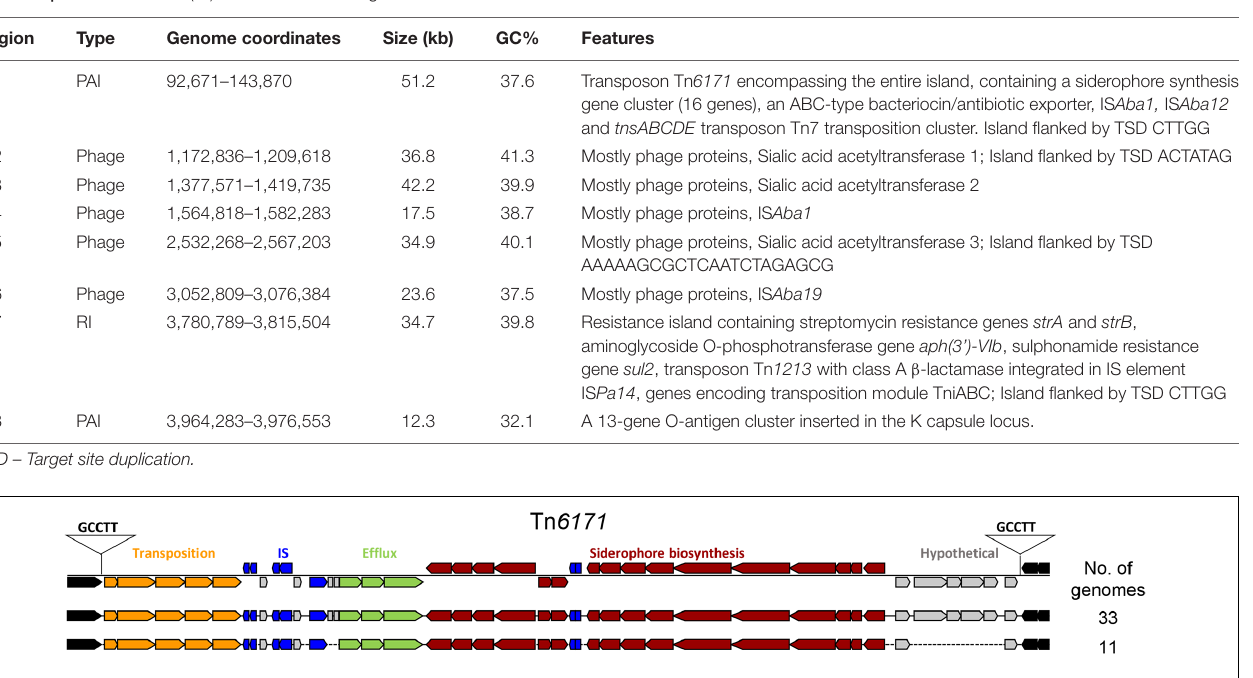
TABLE 1 | Genomic Islands (GI) identified within the genome of strain AbPK1.